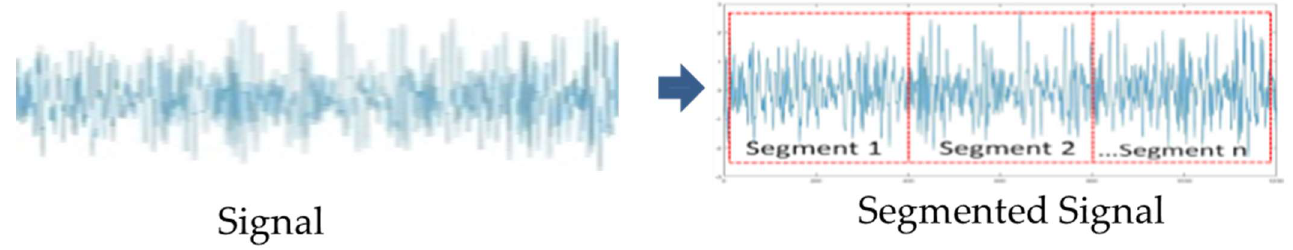
Figure 2. Signal Figure 2. Signal segmentation.